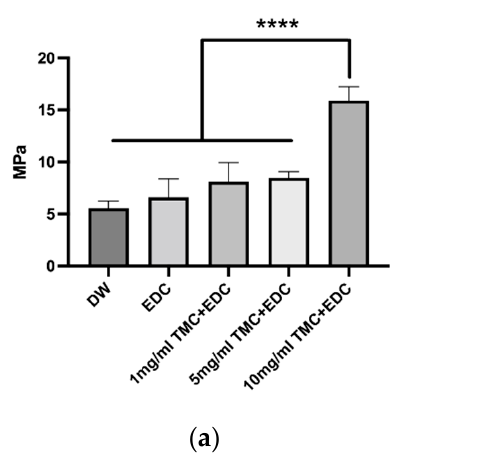
Figure 4. ( a ) The percentage of dry weight loss in each group; ( b ) The release of HYP in each group. (ns, no statistical significance; **, p < 0.01; ****, p < 0.0001).